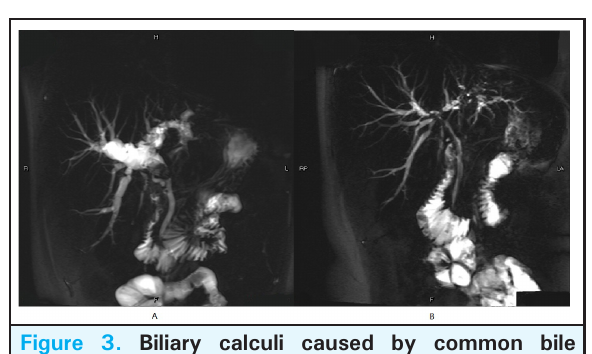
Figure 3. Biliary calculi caused by common bile duct anastomotic stenosis before(A) and